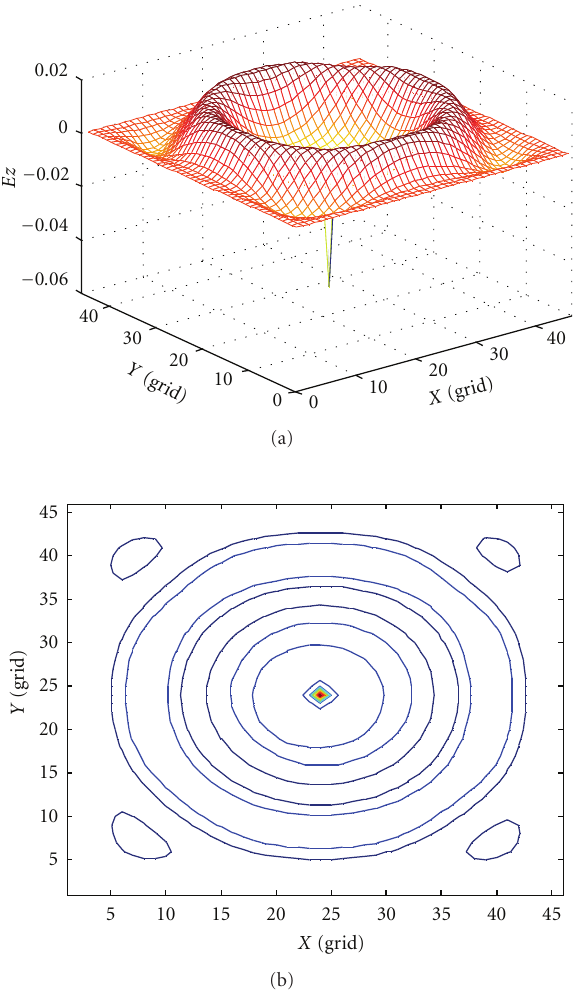
Figure 4: Radiation from a dipole with a ten-point PML. (a) The distribution of the Ez field. (b) The contour of the Ez amplitude field.